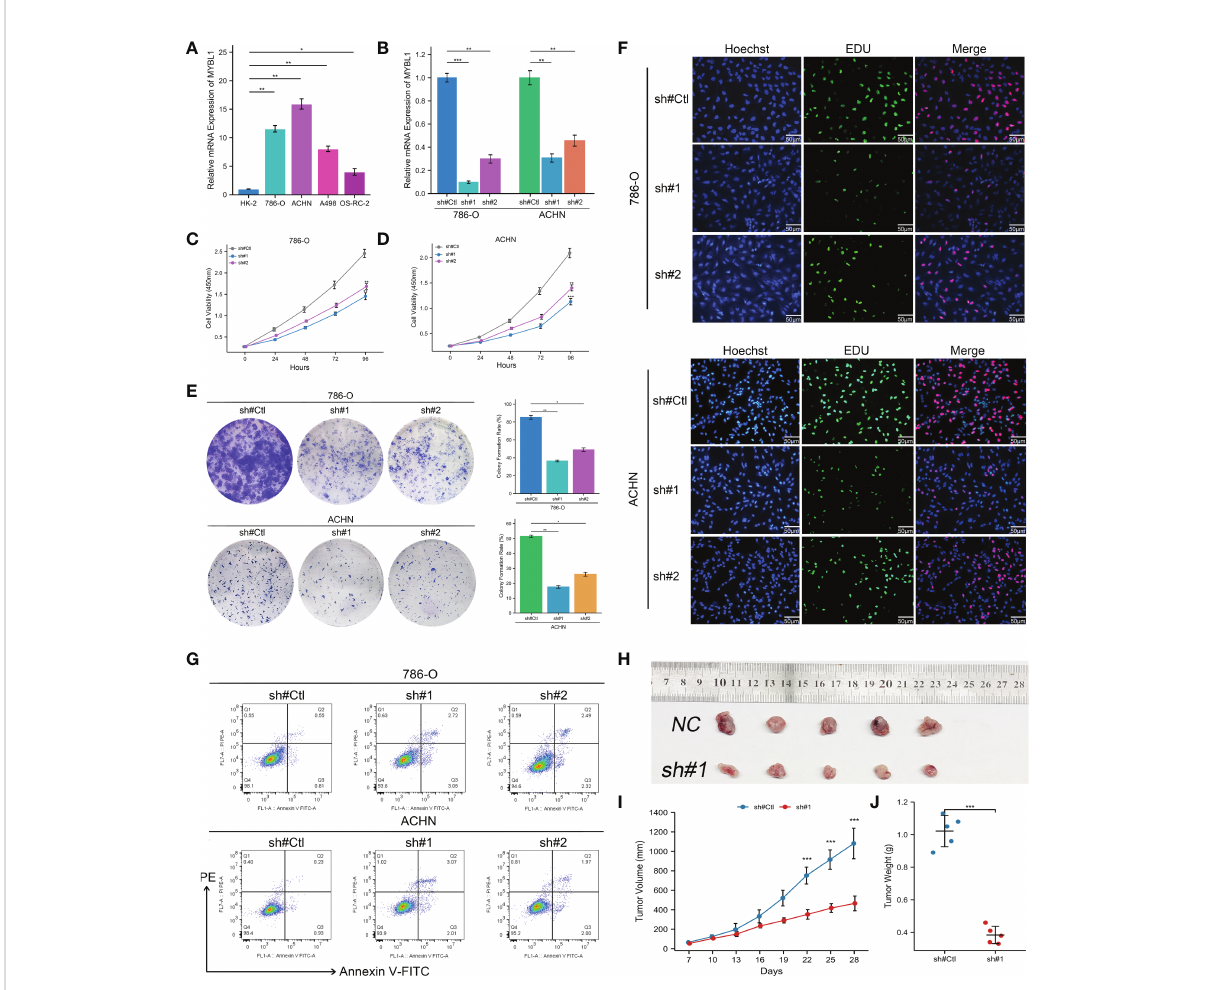
FIGURE 6 MYBL1 enhances the malignant biological behaviors of ccRCC cells. (A) The expression level of MYBL1 in renal cancer cells; (B) Knockdown ef fi ciency of MYBL1 in ccRCC cells; (C, D) CCK8 assay between sh-MYBL1 and control cells; (E) Colony formation assay between sh-MYBL1 and control cells; (F) EdU assay between sh-MYBL1 and control cells; (G) Flow cytometry detecting cell apoptosis between sh-MYBL1 and control cells; (H – J) In vivo assay showed that the inhibition of MYBL1 could also hamper tumor growth in mice. *P < 0.05, **P < 0.01, ***P <